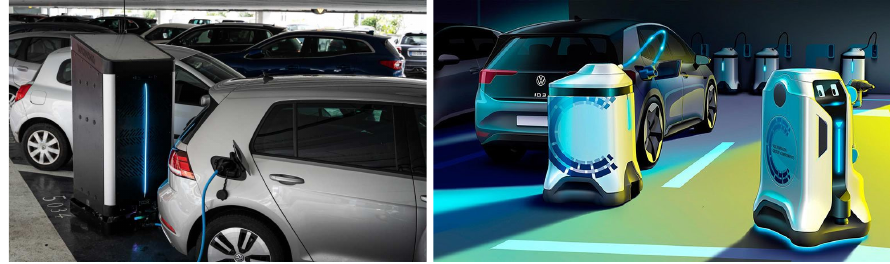
Figure 2. Mobile charging stations from Mob-Energy [10] and Volkswagen